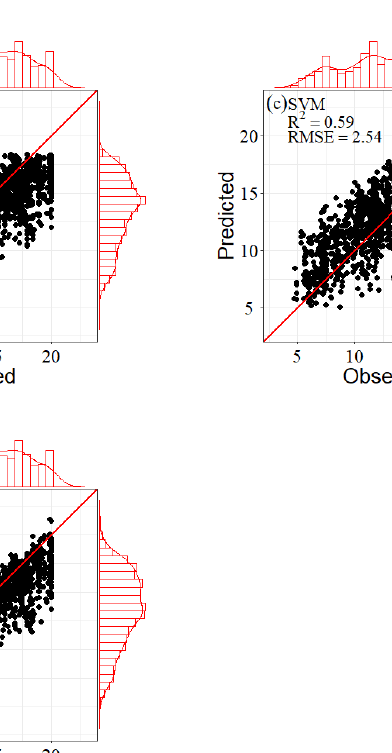
Figure 5. Importance ranking (with standard deviation) of the ASR and height metrics obtained using random forest.